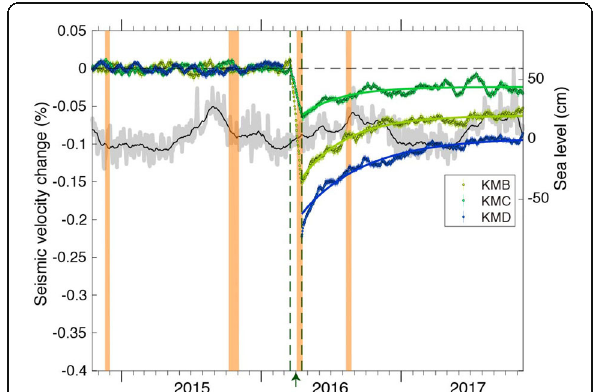
Fig. 8 Temporal variation of average seismic velocity in each node (colored dots) after removing long-term trend. Symbols are the same as in Fig. 4. The solid lines represent the exponential models of Eq. (6) obtained by curve